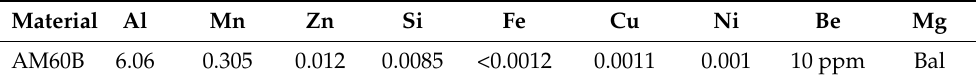
Table 3. Base composition of the AM60B alloy.